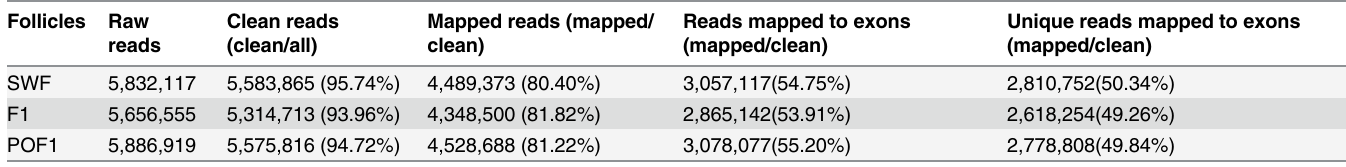
Table 1. Summary of RNA-seq metrics from chicken follicle transcriptomes. Follicles Raw